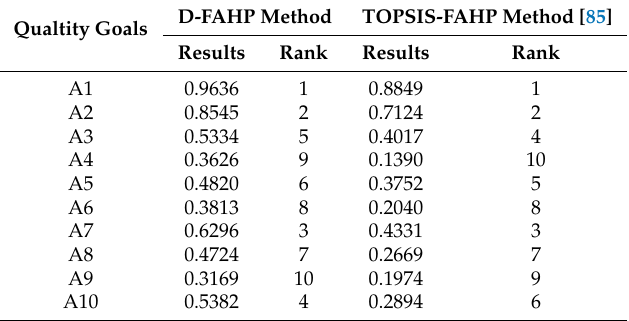
Table 10. The final results of evaluation quality goals by D-FAHP method and TOPSIS-FAHP